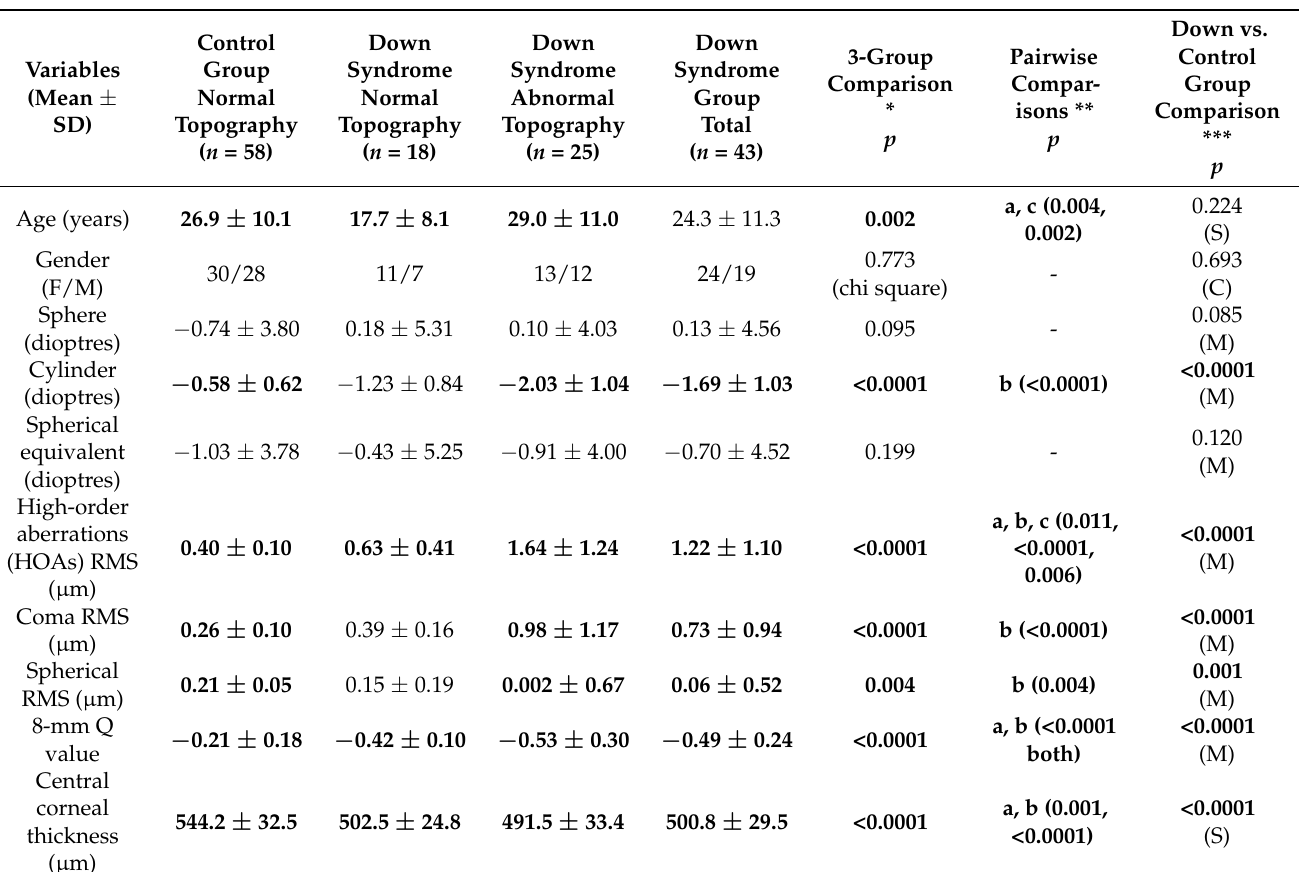
Table 1. Comparison of the control and Down syndrome groups regarding age, gender, refractive, aberrometric and pachymetric